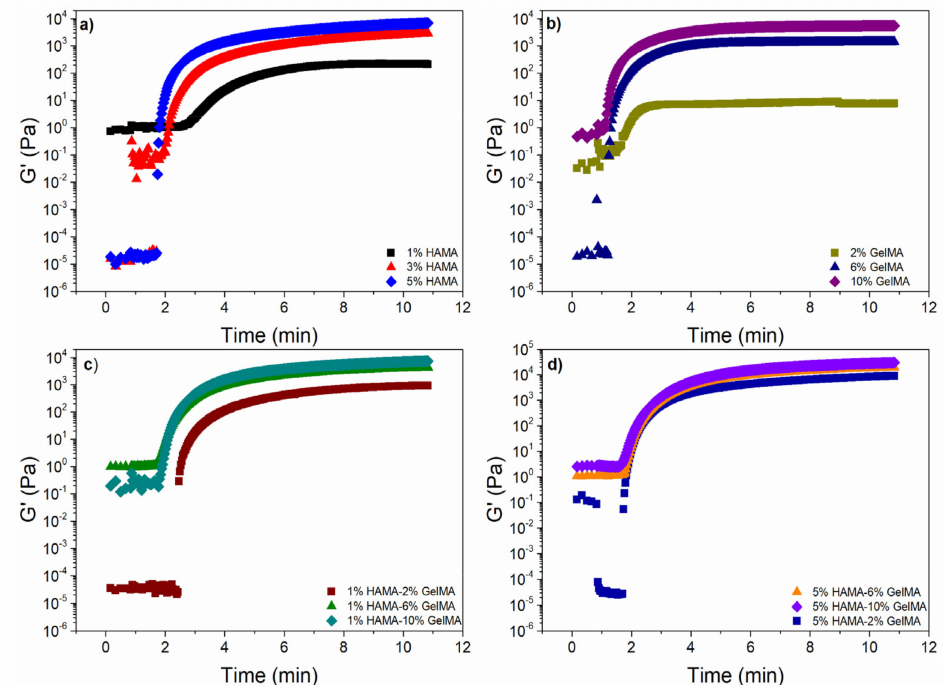
Figure 4. Storage modulus (G (cid:48) ) as a function of the crosslinking time for different concentrations of ( a ) HAMA; ( b ) GelMA; ( c ) 1%HAMA-X% GelMA; and ( d ) 5% HAMA-X% GelMA at 37 ◦